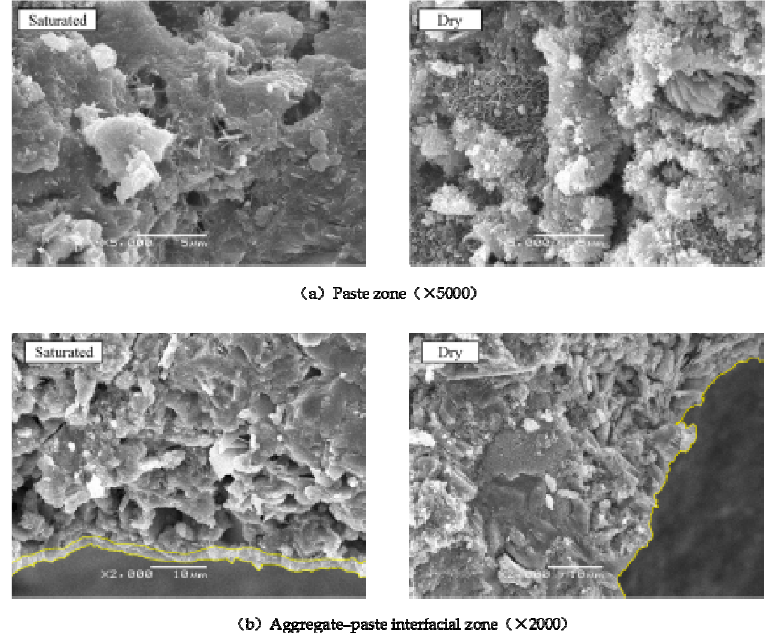
Figure 8. SEM images of dry and saturated specimen.